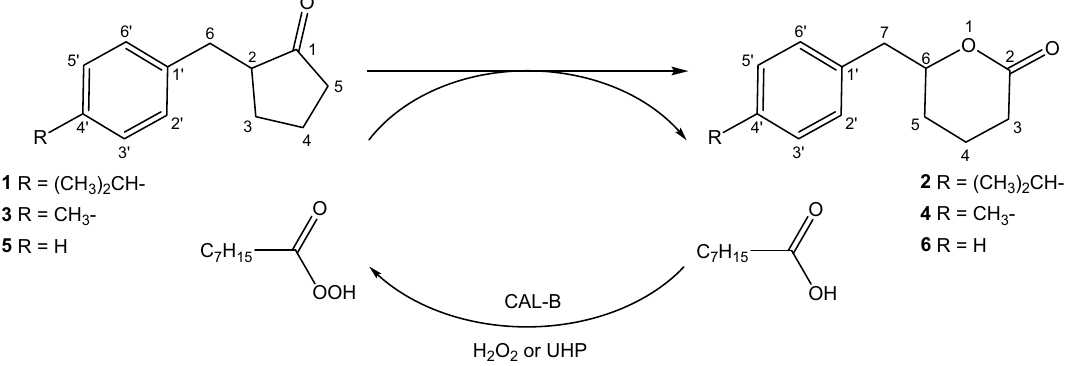
Figure 1. Chemo-enzymatic Baeyer–Villiger oxidation of α-benzylcyclopentanones in different mDESs.